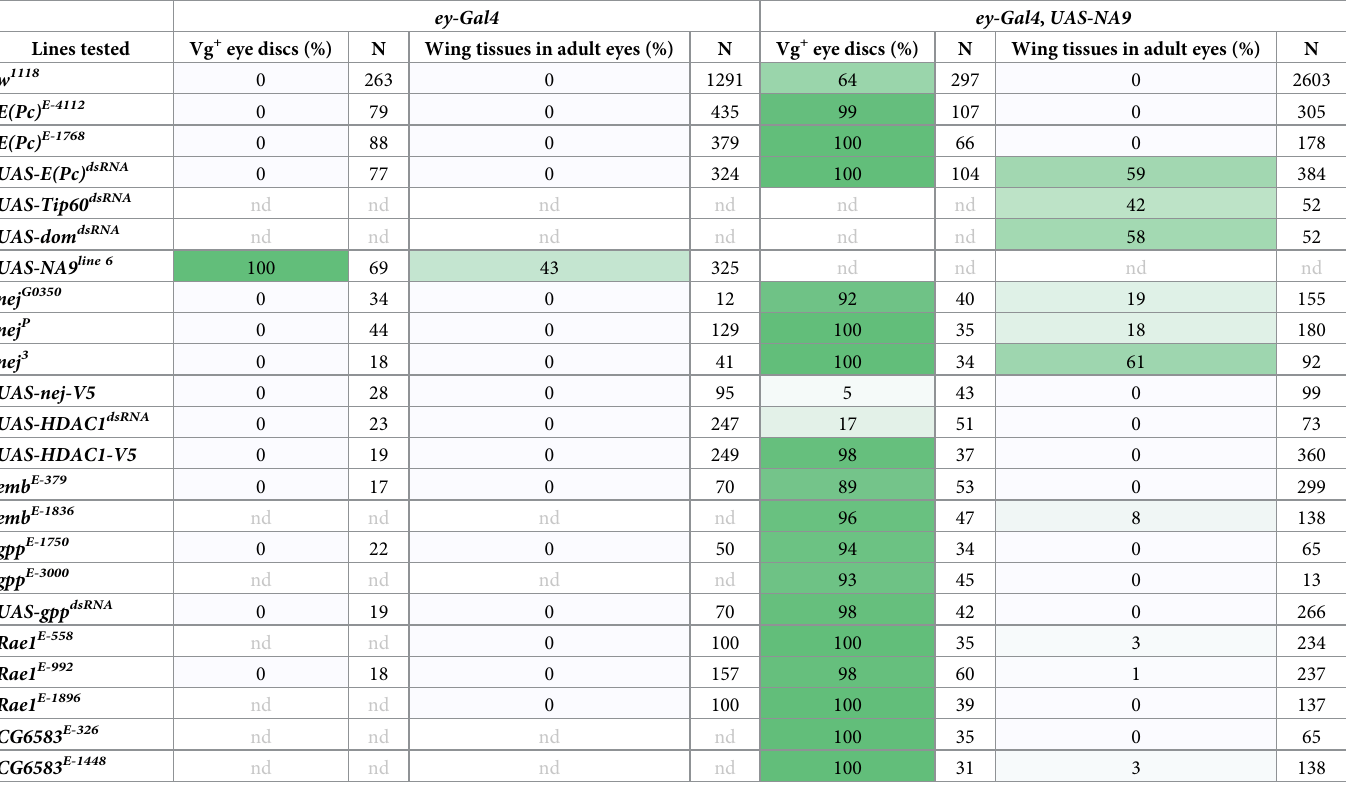
Table 2. Quantification of NA9 -induced eye-to-wing